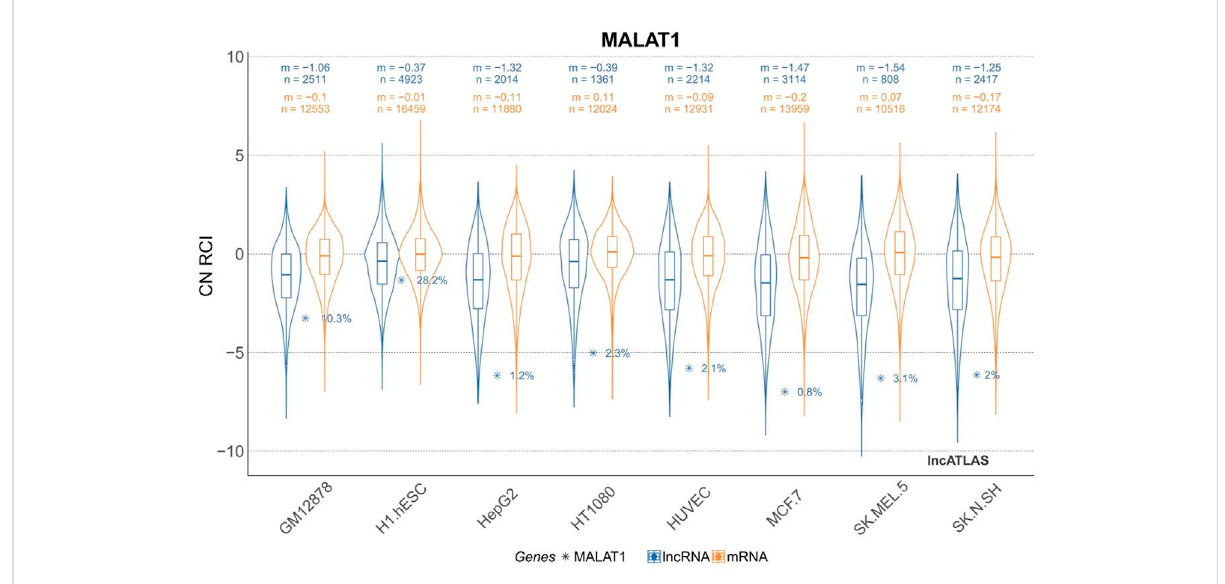
FIGURE 2 Cytoplasmic-to-nuclearrelativeconcentrationindex(RCI)ofMALAT1indifferentcell lines.m,medianRCIvaluepergroup;n,numberofgenes per